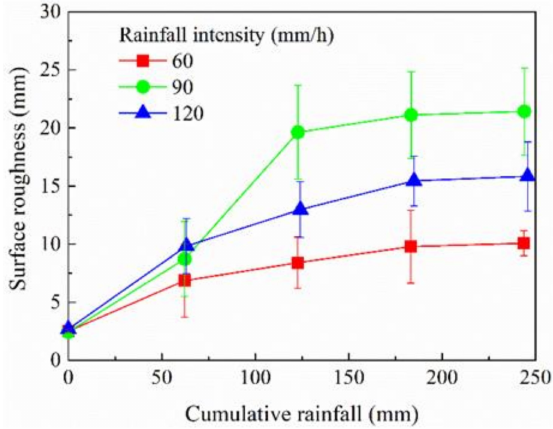
Figure 2. Change of the soil surface roughness with cumulative rainfall (four rainfall sequence in four days, 60 mm/day, the same below).